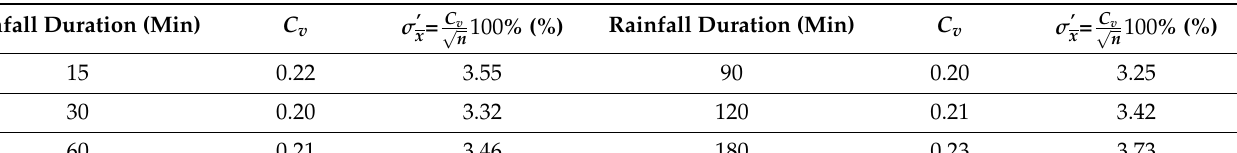
Table 1. Coefficient of variation and average relative error of maximum rainfall over each period at Can Tho station.